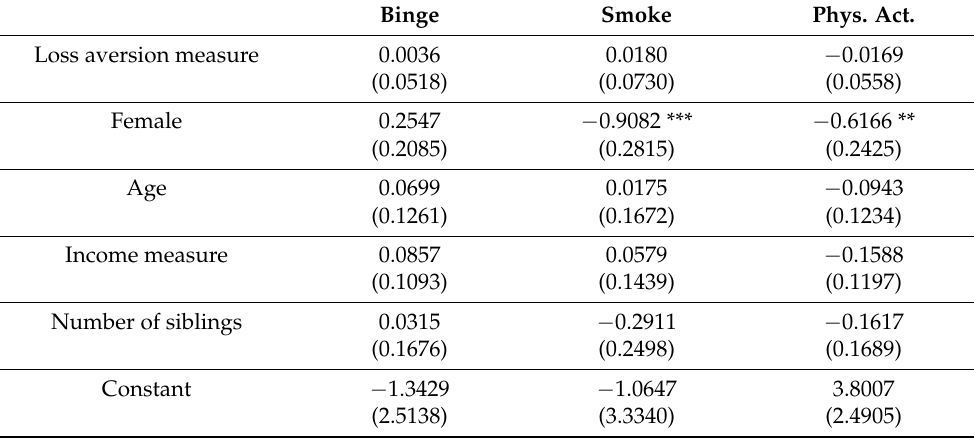
Table A4. Regression results with fewer control variables, US sample. ***, **, and * denote significance levels of 1%, 5%, and 10%,